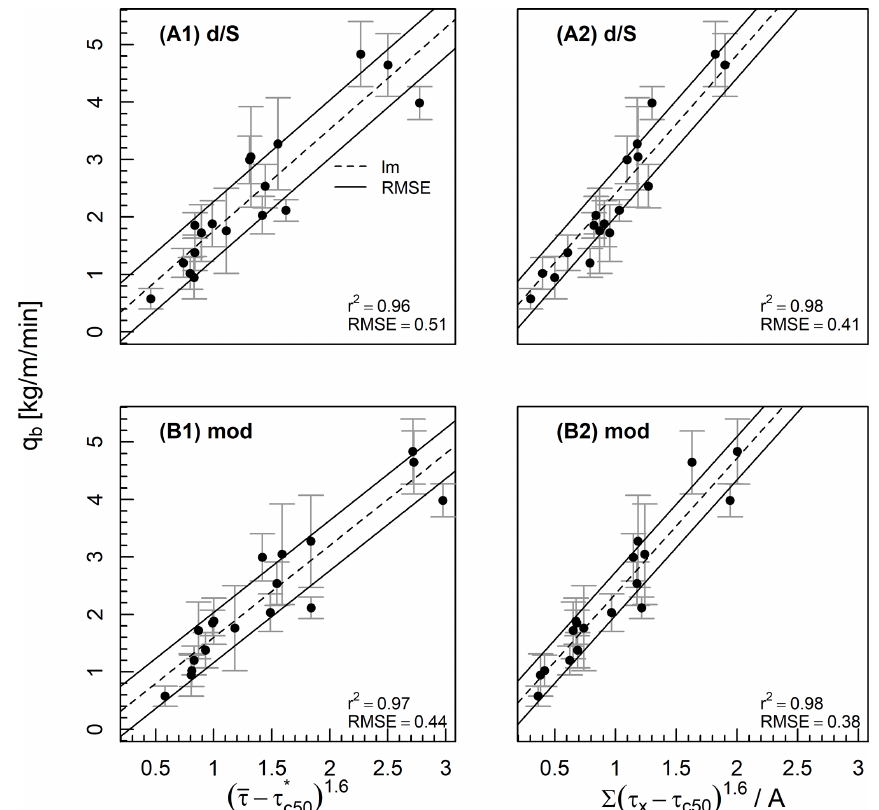
Figure 9. Correlation between excess shear stress and observed bedload transport (averaged over the final 3h of each experiment) using the four approaches outlined in Table 4. The dashed black line is the least-squares best fit, solid black lines indicate ± 1RMSE, and whiskers indicate ± 1standard deviation over the final 3h of sediment output